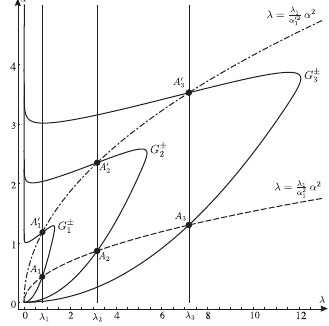
Figure 4. The solution curves G ± j = 1 , 2 , 3) of the problem (1.8), where j ( f ( x ) = h + ( x ) = x 1 2 + x 32 , g ( x ) = h − ( − x ) = x 1 2 + x 32 , x ≥ 0 and b − a = 2 . 5. The points A j ( j 2 λ 1 ,jα 1 ) ∈ G ± j and A ′ j ( j 2 λ 1 ,jα ′ 1 ) ∈ G ± j lie on the parabolas λ = λ 1 α 2 and λ = λ 1 α ′ 2 1